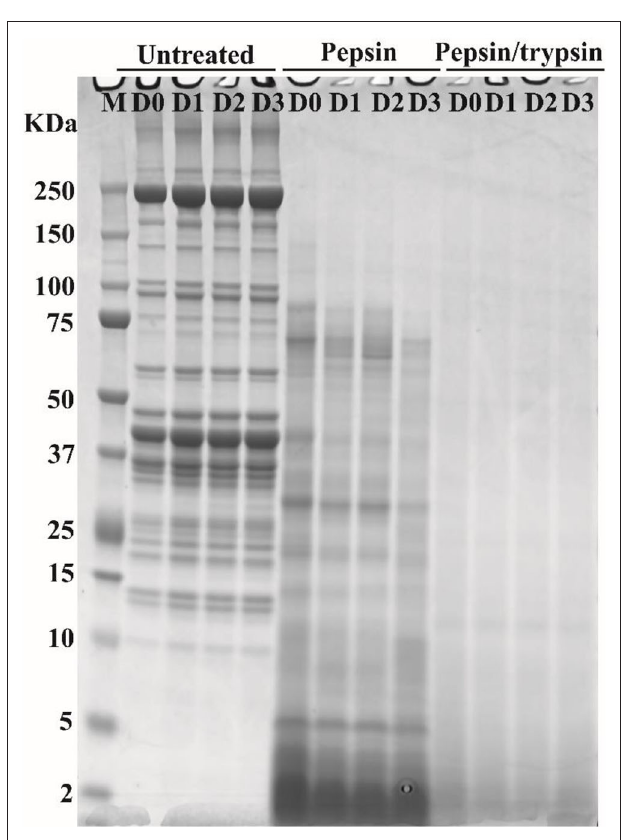
FIGURE 3 | Typical SDS-PAGE patterns of pork proteins before and after digestion. “Untreated” represents total proteins in cooked pork before digestion. Pepsin represents ethanol-insoluble fraction after pepsin digestion. Pepsin/trypsin represents ethanol-insoluble fraction after pepsin and trypsin treatments. Lanes M, D0, D1, D2, and D3 represent calibration marker, 0, 1, 2, and 3 d samples.